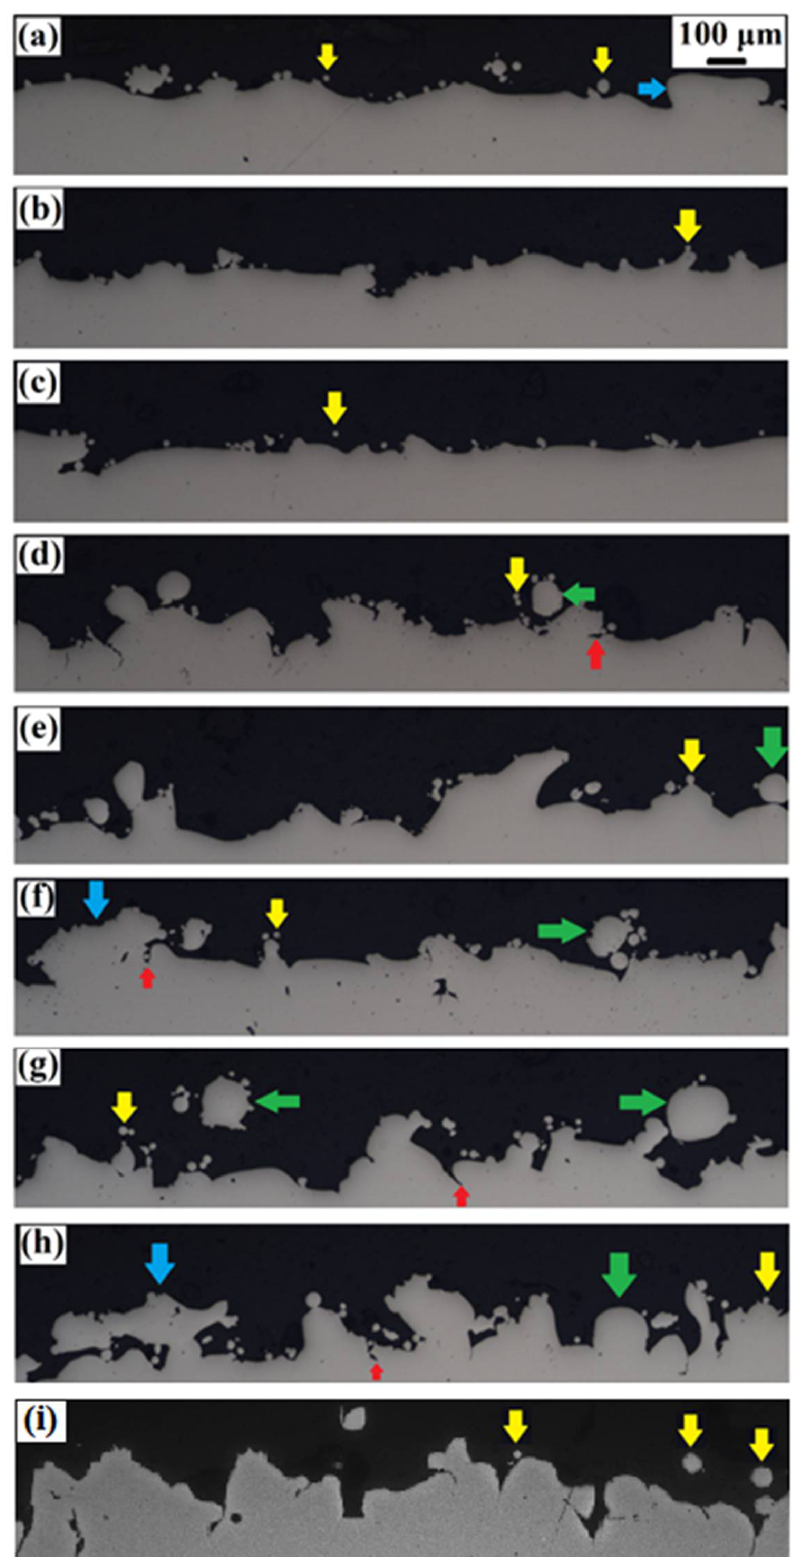
Figure 6. Cross-section OM images obtained from: ( a ) US-45°, ( b ) CS-45°-250 μm, ( c ) CS-45°-300 μm, ( d ) US-30°, ( e ) CS-30°-250 μm, ( f ) CS-30°-300 μm, ( g ) US-25°, ( h ) CS-25°-250 μm, and ( i ) CS-25°-300 μm.